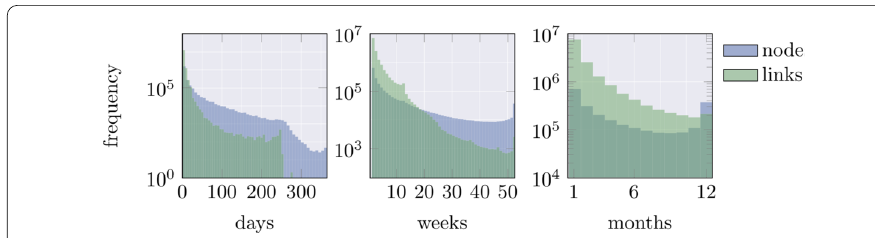
Figure 8 Number of nodes (blue) and links (green) for each day, week, and month. Only with longer time aggregations one is able to eliminate